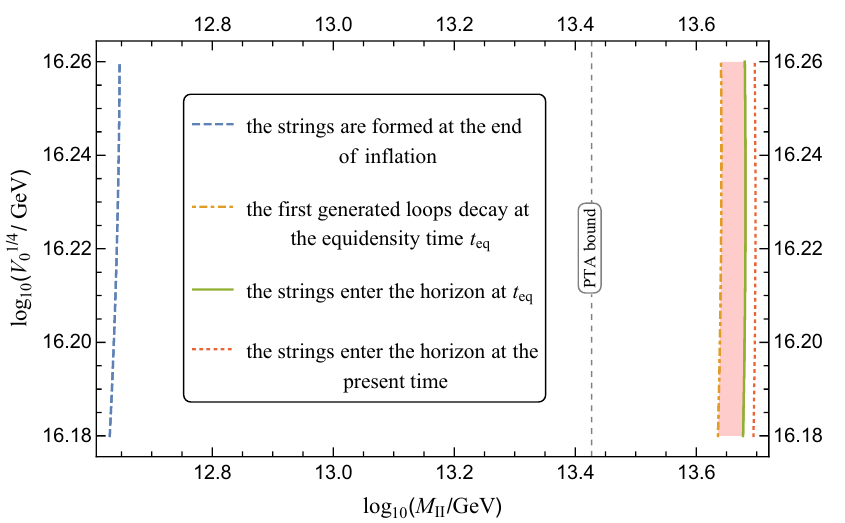
( V 1 / 4 / GeV) ∈ 10 0 , 3. strings eq